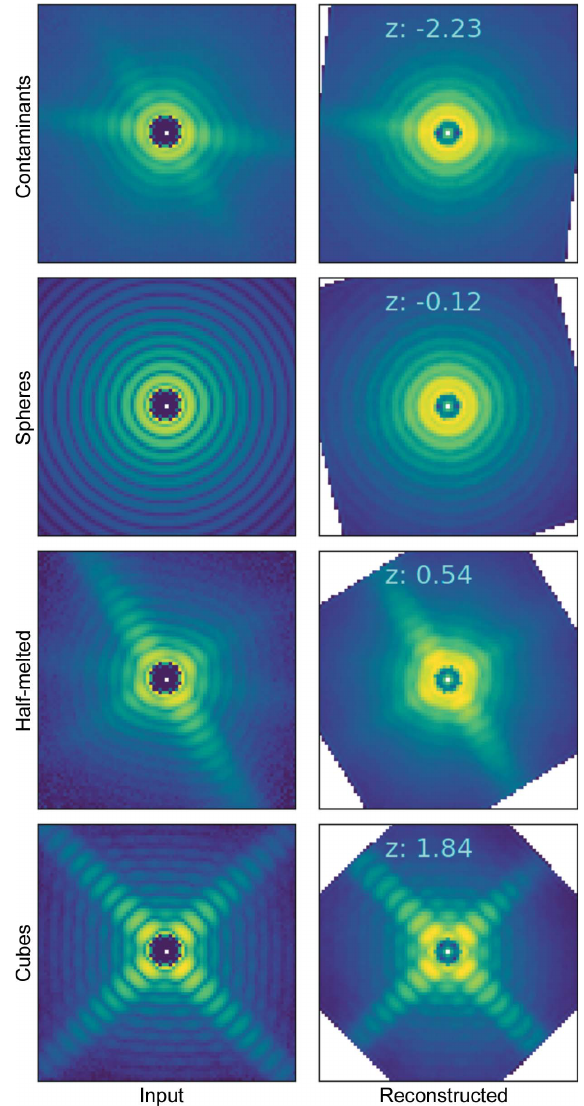
Figure 8 The left-hand column shows input intensities X to our VAE model, and the right-hand column shows VAE-reconstructed intensity patterns X 0 on a logarithmic scale.